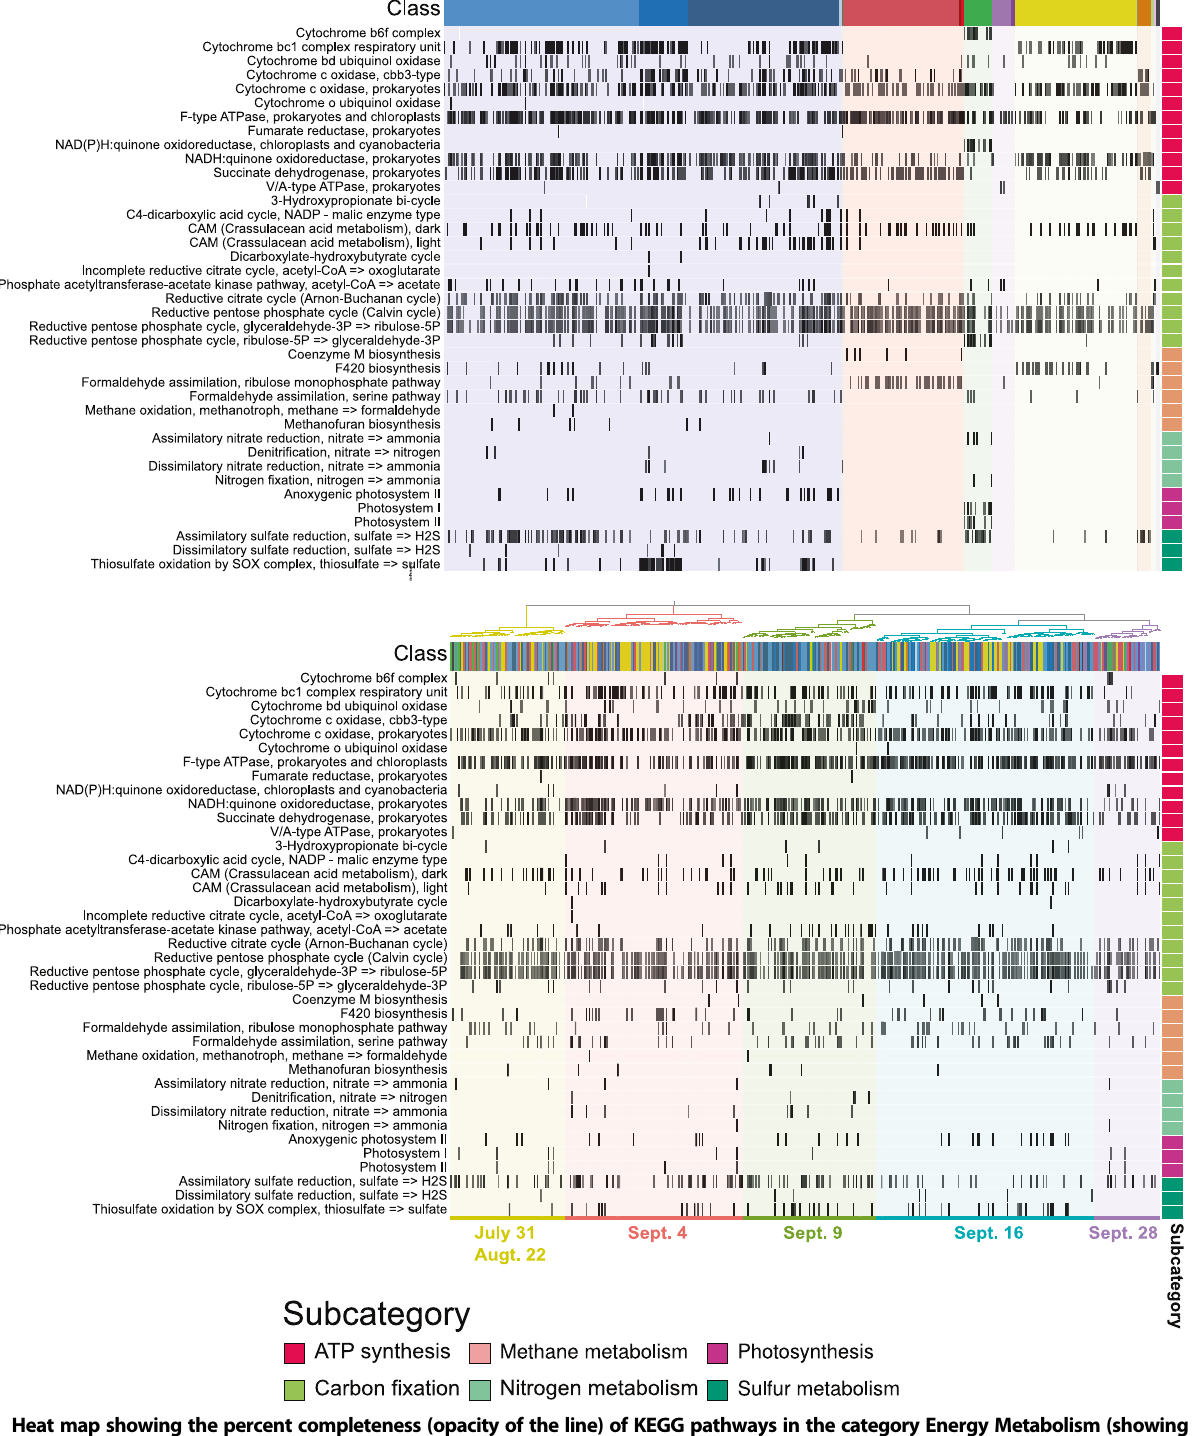
Fig. 7 Heat map showing the percent completeness (opacity of the line) of KEGG pathways in the category Energy Metabolism (showing only modules with> 50% genes in each pathway). The MAGs were grouped according to taxonomic classi fi cation ( A ) and hierarchical clustering of the MAG percent community ( B ). Each column represents a MAG while each row represents a KEGG metabolism module The redundancy in metabolism was assessed by the calculation of to dissimilatory sulfate reduction and the SOX complex were metabolic overlap for the total community and the dominant phyla exclusive to Proteobacteria (Fig. 7A). Genes predicted to be (Fig. 8). The median metabolic overlap for the entire community is involved in assimilatory sulfate reduction were prevalent similar to calculations made in Hester et al. [45] for marine systems. throughout all sampling dates; however a majority of MAGs Additionally, we found that photosynthesis, nitrogen metabolism, containing genes involved in the SOX complex (47 of 49 MAGs) and xenobiotic degradation and metabolisms had median metabolic and dissimilatory sulfate reduction (6 of 7 MAGs) clustered on overlap scores of 0, indicating that these are rarer metabolisms Sept. 4, Sept. 9, and Sept. 16 (Fig. 7B).